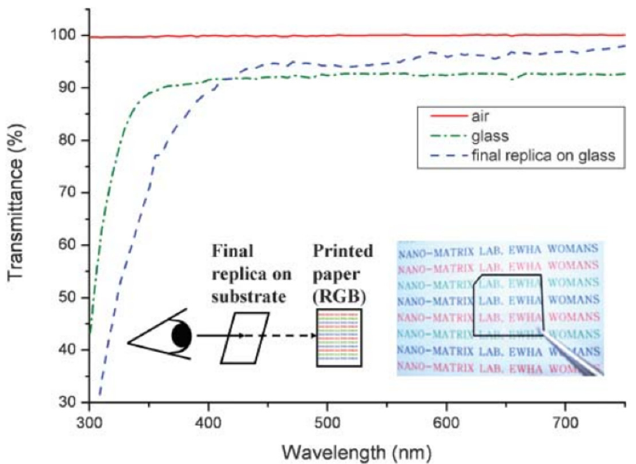
Figure 14. The transmittance of the highly transparent super-hydrophobic surface and a photograph of letters underneath the transparent superhydrophobic film [40].